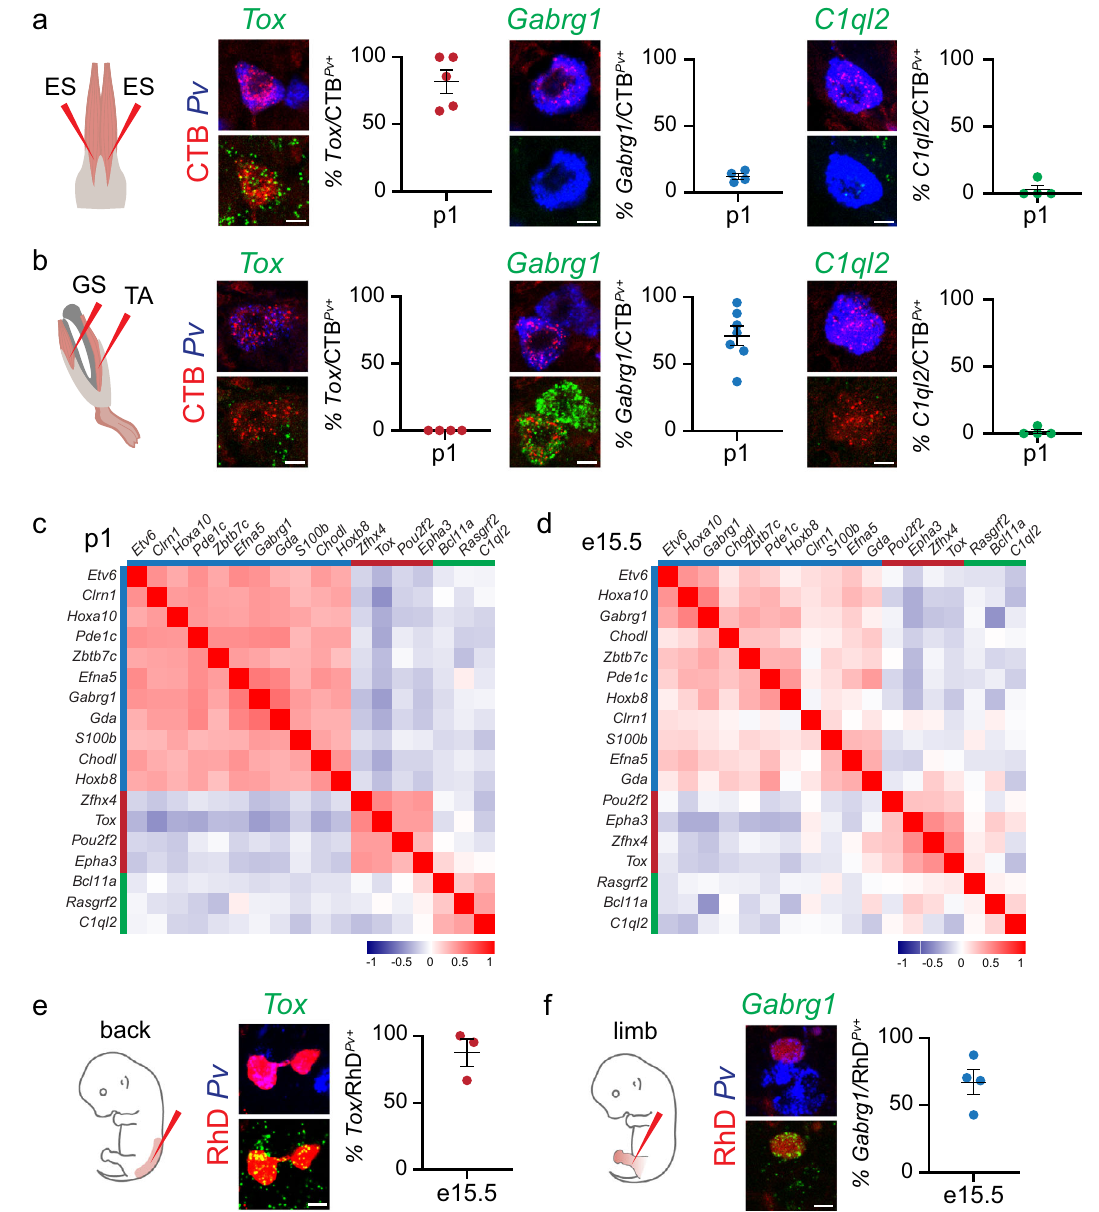
Fig. 4 | Proprioceptors muscle-type identity emerges at early developmental stages. a , b Representative smFISH images and quanti fi cation of Tox (C2), Gabrg1 (C3), and C1ql2 (C4) expression in Pv + sensory neurons retrogradely labeled after cholera-toxin B (CTB) injection in back ( a erector spinae, ES) and hindlimb ( b gastrocnemius, GS and tibialis anterior, TA) of p1 wild-type mice (mean±SEM, n ≥ 4 animals). Scale bar: 10 µ m. c , d Heatmaps representing pairwise gene expression correlation values for Ba-pSN (red), Ab-pSN (green), and Li-pSN (blue)